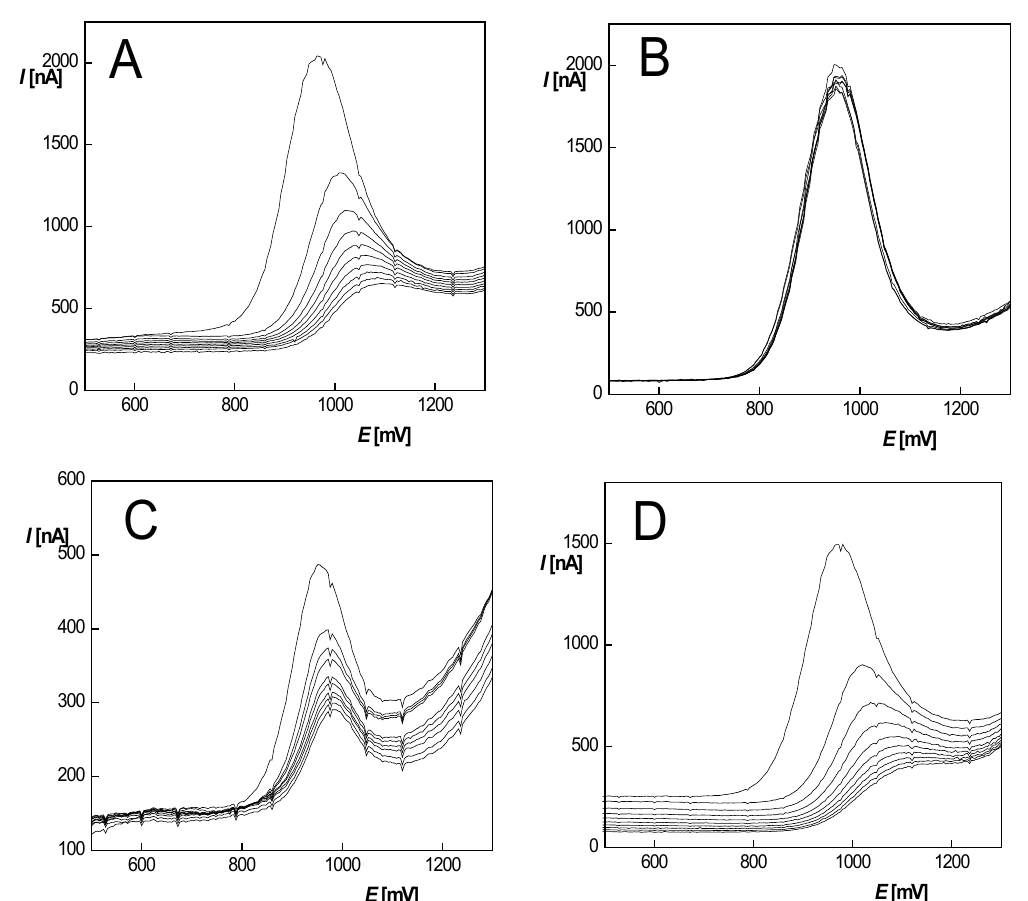
Figure 2. Ten repeated DP volammograms of metoclopramide at BDDFE (A) in BR buffer pH 6, c = 100 µmol L -1 ; (B) in BR buffer pH 6, c = 100 µmol L -1 , activated between measurements; (C) in BR buffer pH 6, c = 10 µmol L -1 ; (D) in BR buffer pH 6 : methanol (1:1, v/v), c = 100 µmol L -1